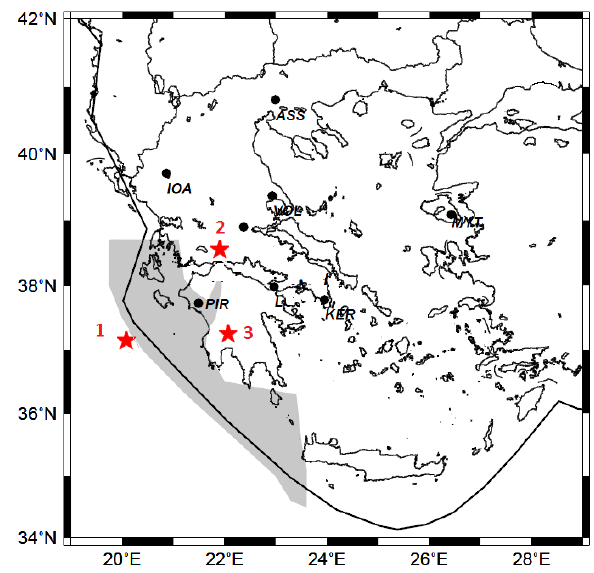
Fig. 2. The selectivity map (shaded area ) of PIR station. The epicenters of the three main shocks are denoted by red stars with numbers 1, 2 and 3 as listed in Table